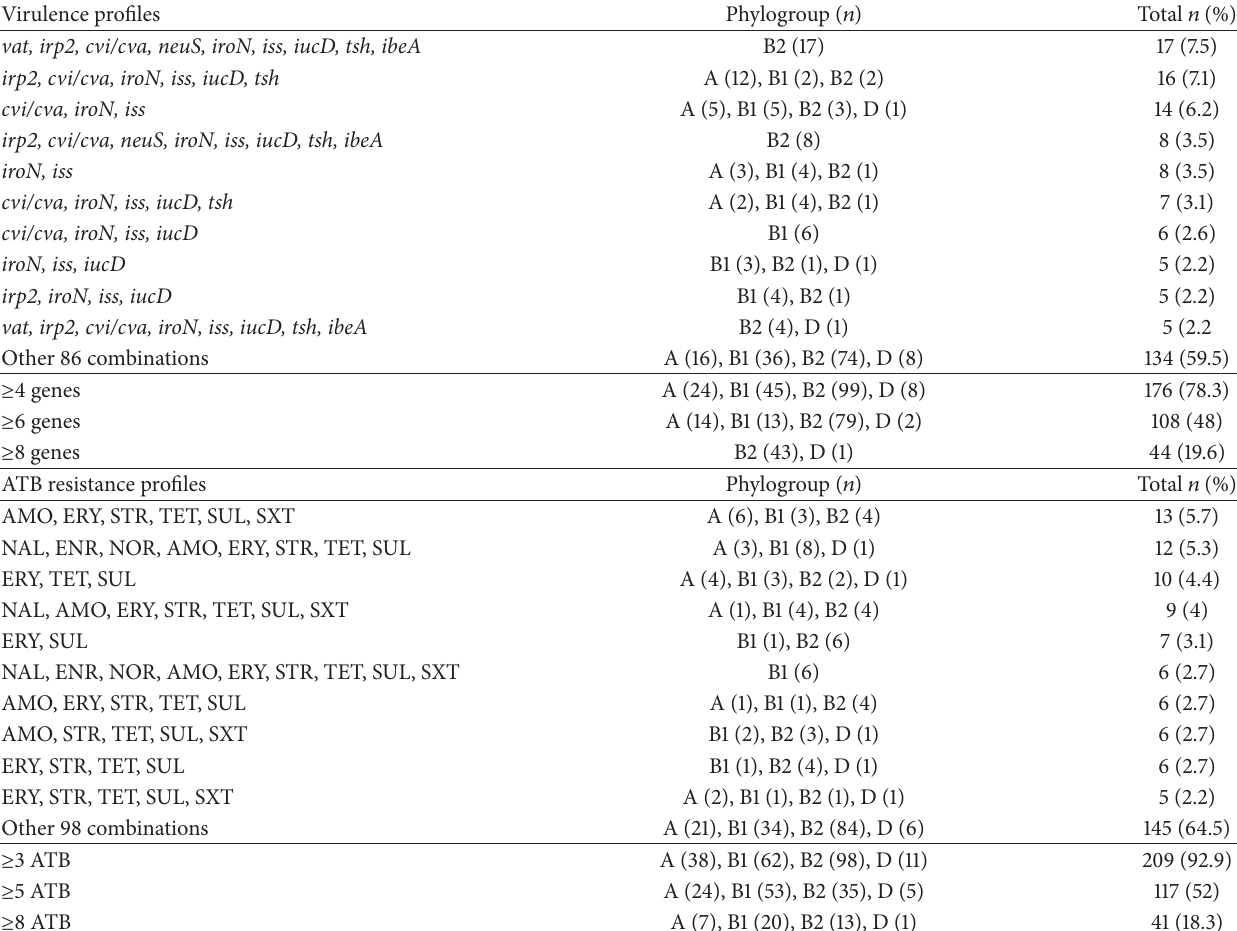
Table 2: Virulence and antibiotic resistance profiles in 225 strains of E . coli